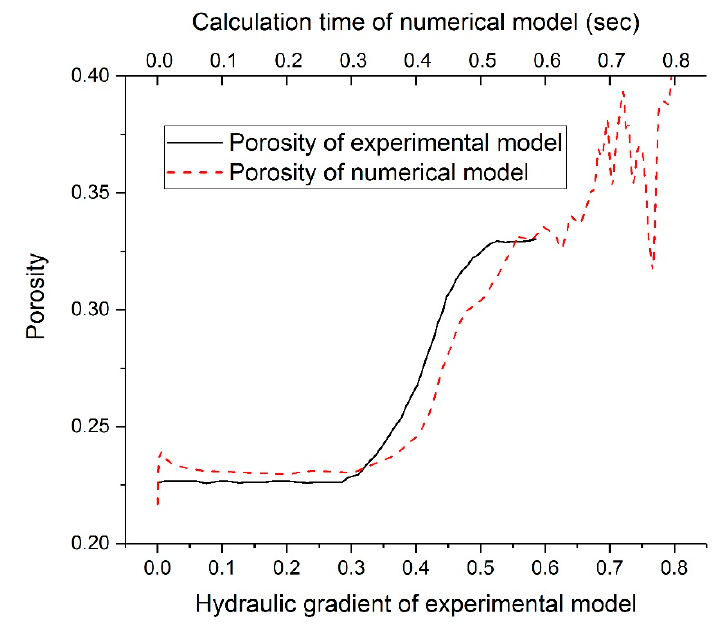
Figure 14. Development of porosity with change in hydraulic gradient.